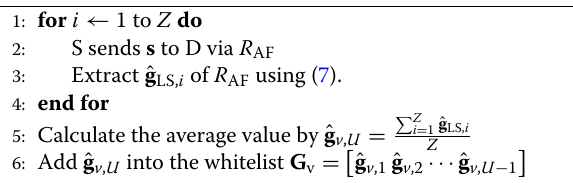
Algorithm 1 Fingerprint registration